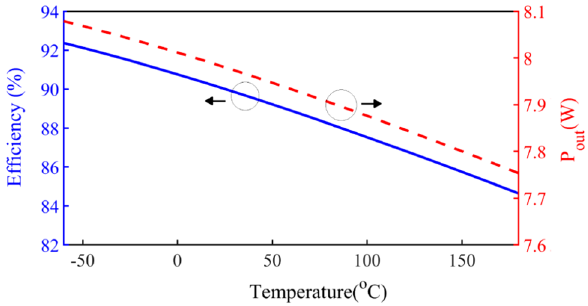
Figure 12. The output power and efficiency.